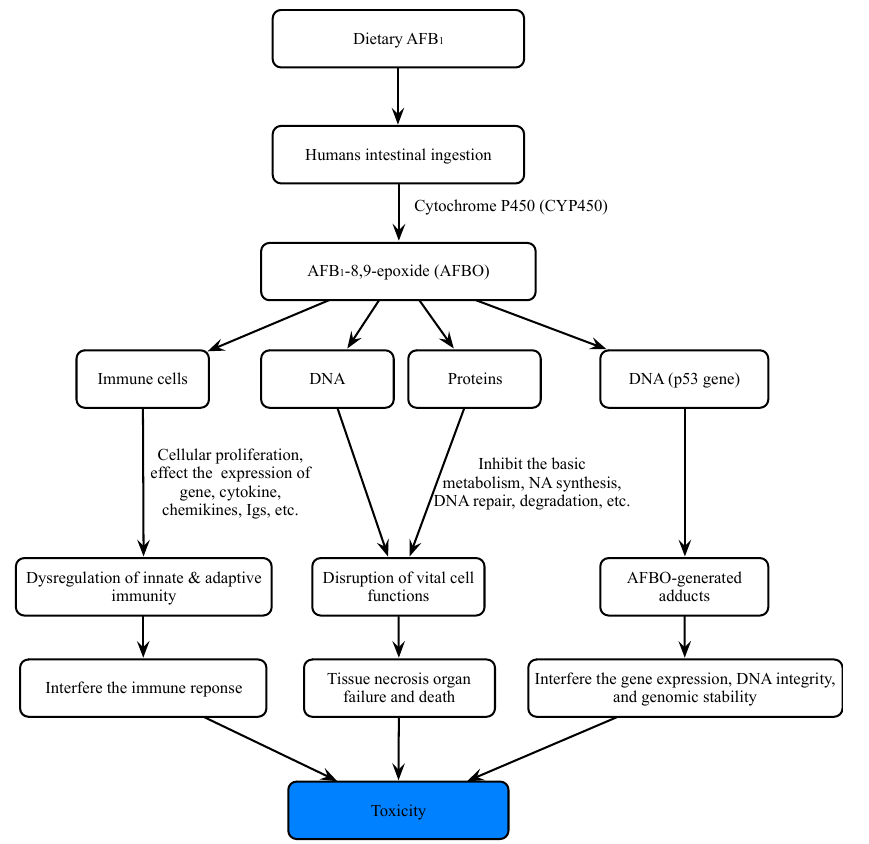
Figure 2. Main mechanisms of toxicity of aflatoxin B 1 for humans.